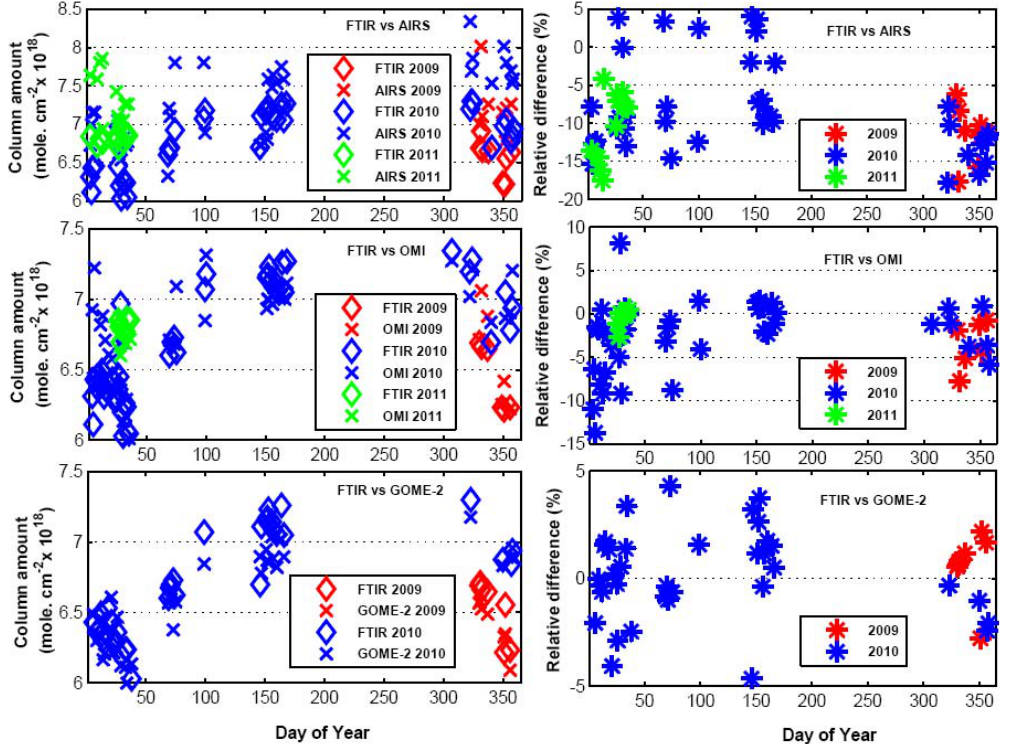
Fig. 8. The same as Fig. 7, but for intercomparison of FTIR with AIRS, OMI and GOME-2 as shown in the figure